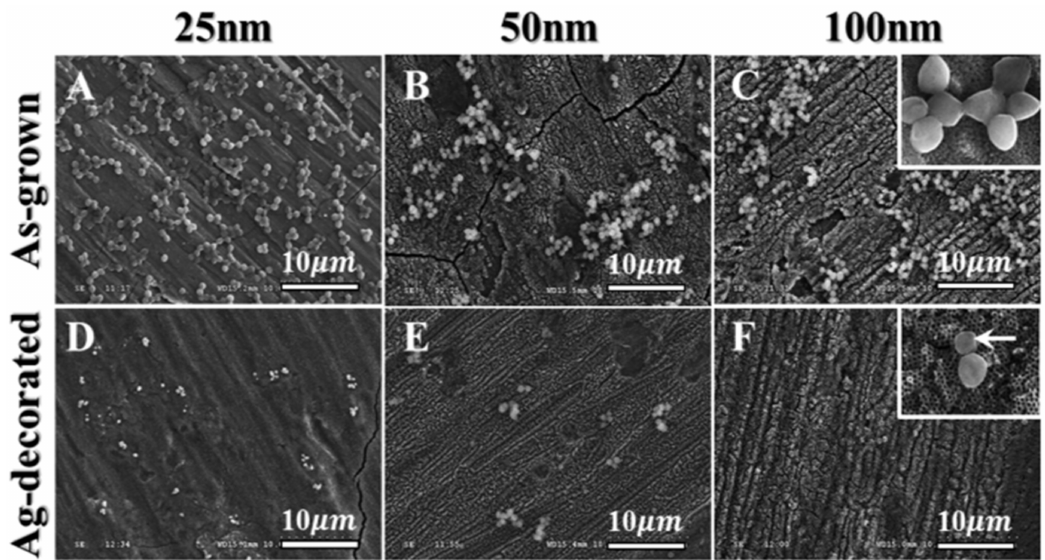
Figure 2. SEM images of S. aureus grown on as-grown or Ag-decorated TiO 2 nanotubes of di ff erent diameters. Numerous bacteria colonies on the as-grown nanotubes ( A – C ), while only a few bacteria could be seen on the Ag-decorated series ( D – F ) (Reproduced with permission from Lan et al., Both Enhanced Biocompatibility and Antibacterial Activity in Ag-Decorated TiO2 Nanotubes; published by PLOS ONE, 2013, CC BY 4.0 [44]).